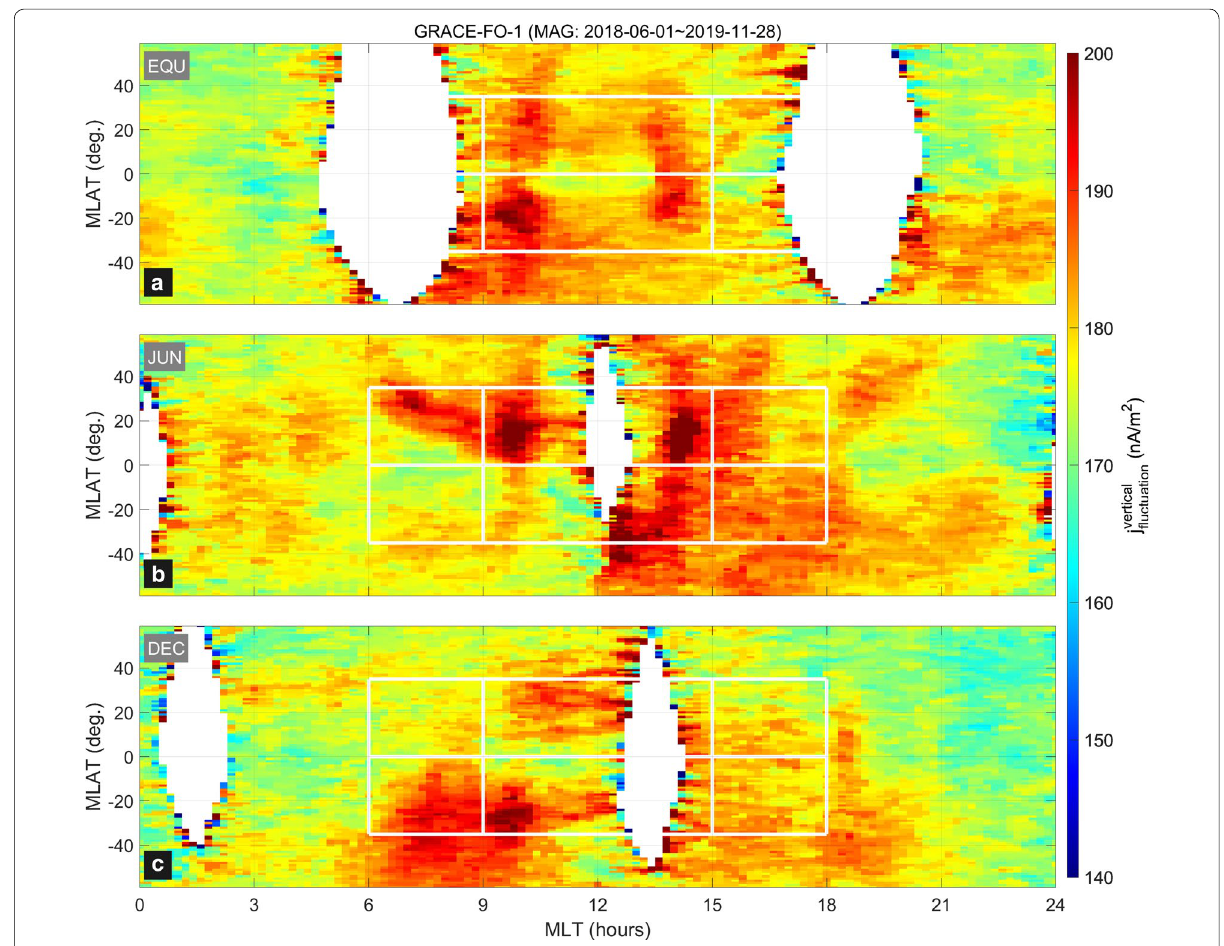
Fig. 11 The same as Fig. 10, but for